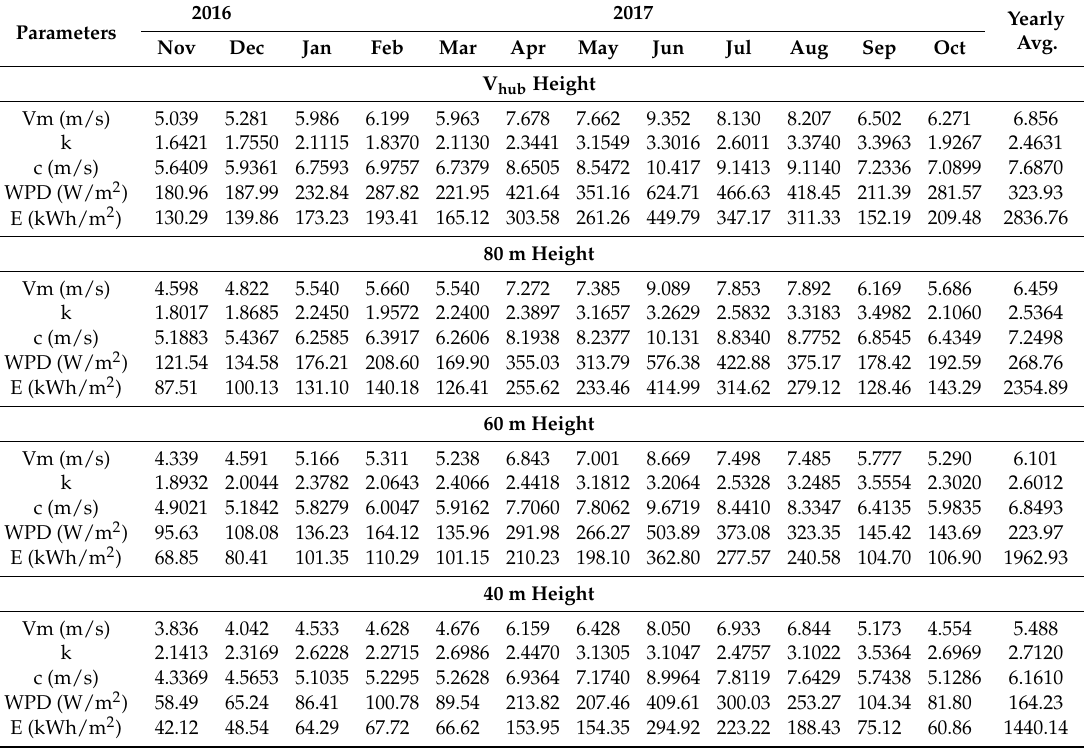
Table 3. Sanghar monthly mean and yearly wind